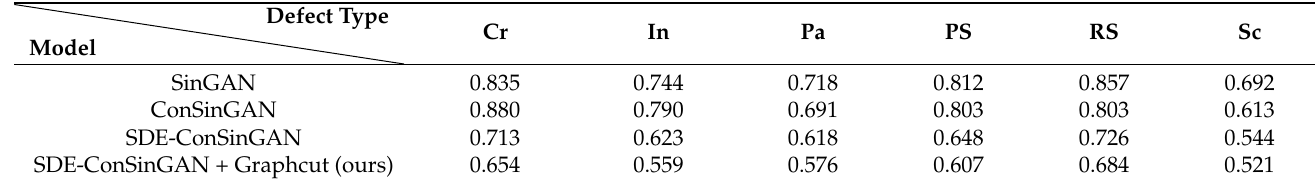
Table 2. SSIM indices of images generated by several models.